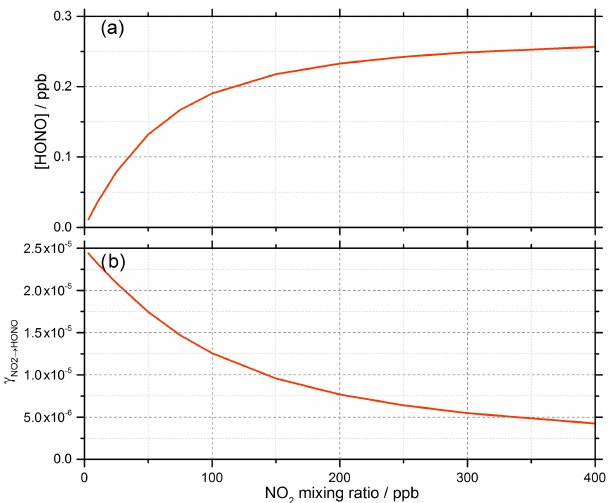
Figure 9. Model 1 calculations for (a) the concentration of HONO and (b) the reactive uptake coefficient to form HONO, γ NO , as a function of NO 2 mixing ratio for a model run 2 → HONO time of 52s. The estimated rate coefficients used in this model are shown in Table